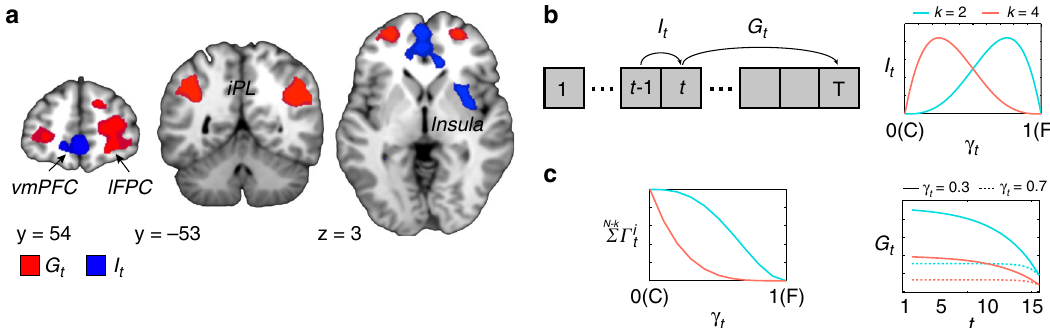
Fig. 3 Neural correlates of ‘ Individual utility ’ and ‘ Group utility ’ from the social learning model. a Activity (in blue) in the ventromedial prefrontal cortex (vmPFC) at the time of feedback on trial t − 1 inversely correlated with individual utility ( I t ) which indicates the expected utility of contribution decision compared with the expected utility of free-riding on the current trial. Activities (in red) in the right lateral frontopolar cortex (lFPC) and bilateral inferior parietal lobule (IPL) at the time of feedback on trial t − 1 positively correlated with the estimated group utility ( G t ), which indicates to what extent a participant expects long-term rewards from the interactions with the group for the remaining interactions. Those areas are thresholded at p < 0.05, FWE corrected at the cluster level. For illustrative purposes, the statistical maps are thresholded at p < 0.005, uncorrected (darker color). The lighter color map was thresholded at p < 0.001, uncorrected. b After the feedback of the previous trial, t − 1, a participant may compute the immediate expected utility for oneself ( I t ) as well as compute the cumulative expected rewards for the group ( G t ) for remaining interactions ( T − t + 1, where T = 15). The right panel is the conceptual illustration of individual utility ( I t ) according to one ’ s belief about the decision of another ( γ ). It correlates with the binomial probability density function of γ t , which indicates one ’ s belief about the probability that one of the other members will free-ride at round t . c Conceptual illustration of group utility ( G t ) according to one ’ s belief about the decision of another ( γ ). G t depends on the probability that the group generates the public goods and the number of remaining trials. (Left) The probability to generate the public goods varies as a binomial cumulative density function given γ t at trial t . (Right) Relationship between G t and γ t . G t is high when participants believe that another player is less likely to free-ride (e.g., γ t = 0.3) compared with when they believe that another player is more likely to free-ride (e.g., γ t = 0.7, dotted line). G t is also discounted by the number of remaining interactions.